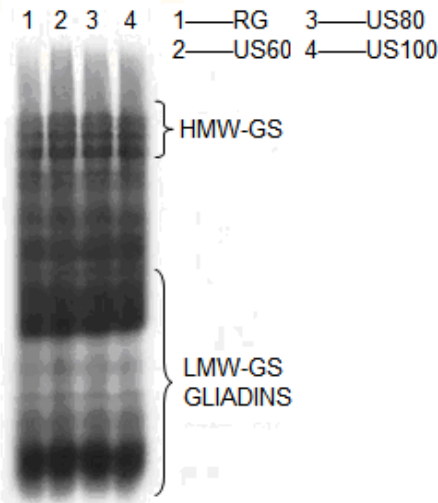
Figure 4. SDS-PAGE of ultrasound treated gluten protein